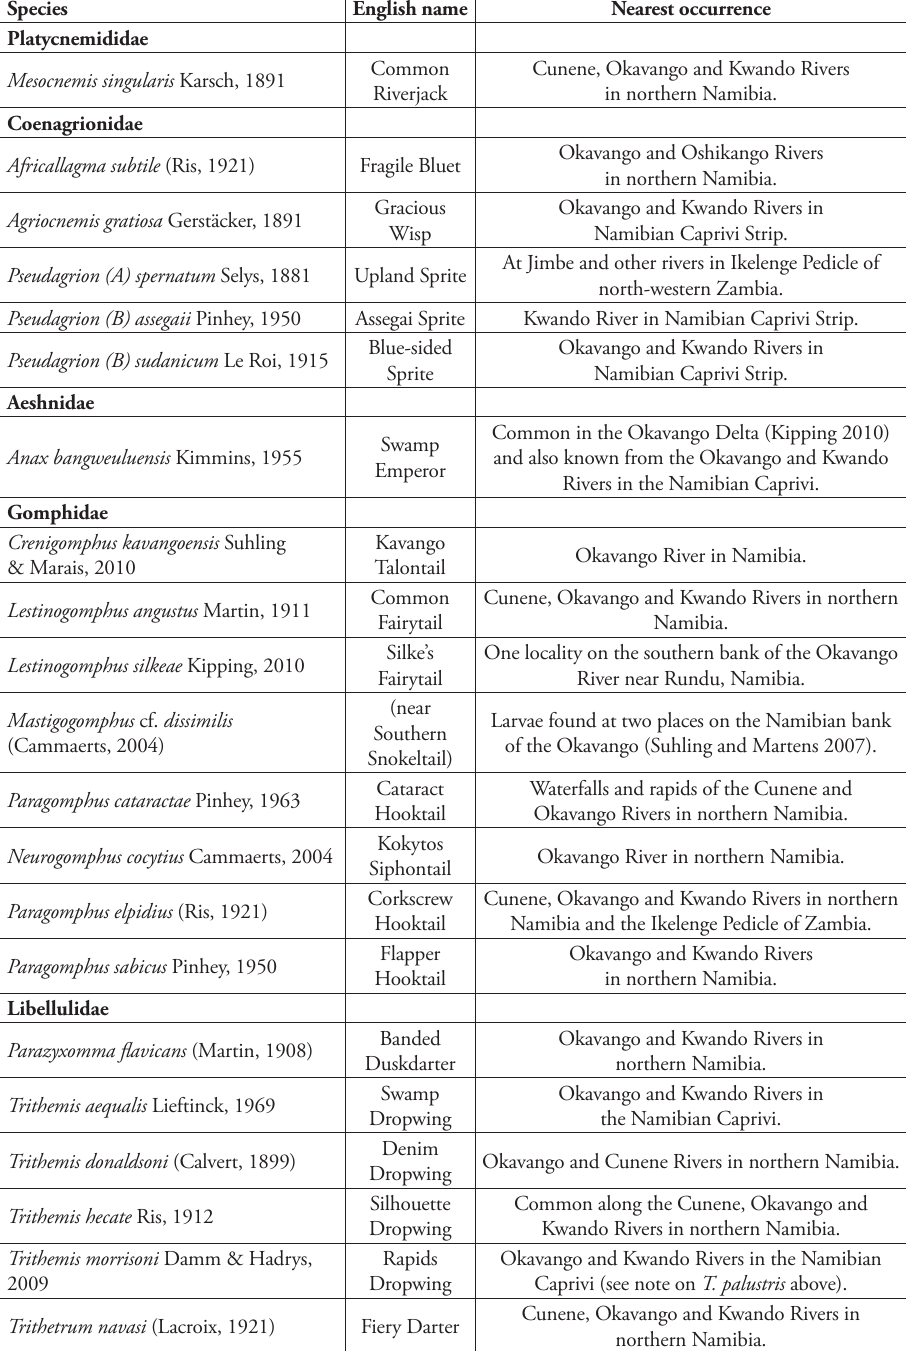
Table 3. Odonata recorded from bordering rivers that most likely occur in Angola